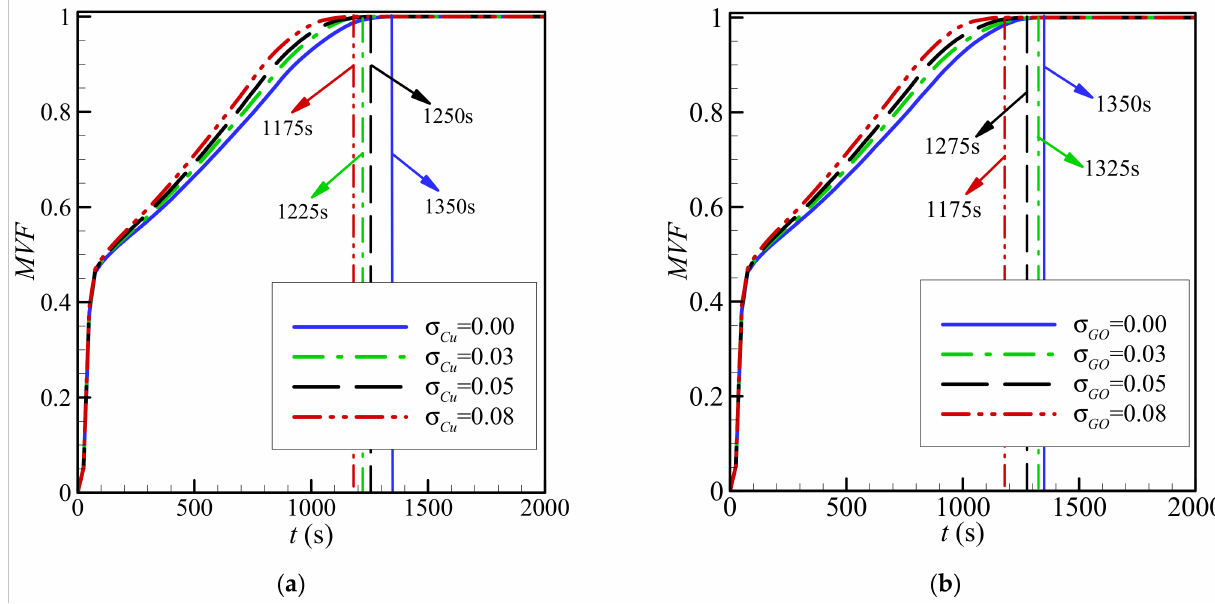
Figure 13. The effects of various volume fractions of copper nanoparticles (eccentricity e = 0.12 r s and porosity ε = 0.8) ( a ) and various volume fractions of graphite oxide nanoparticles (eccentricity e = 0.12 r s and porosity ε = 0.8) ( b ) on the